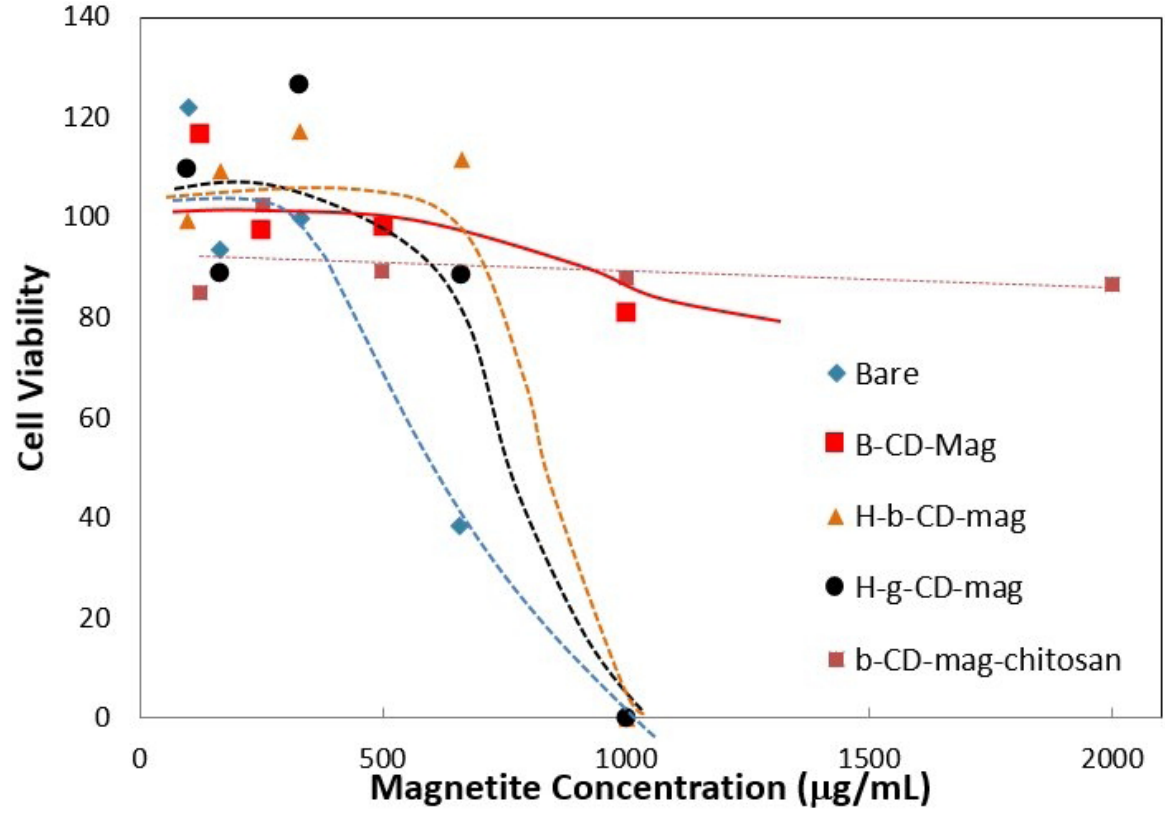
FIGURE 7 - Cell Viability versus magnetite concentration for CD-coated magnetite nanoparticles and chitosan embedded magnetite nanobeads. The connecting lines are placed as a guide to the eye. Magnetite nanoparticles do not possess toxicity of up to 330 µ g/mL, while viability further increased after functionalization of particles by different types of CDs. Encapsulation of b -CD functionalized magnetite nanoparticles in chitosan nanobeads further increased the biocompatibility of the